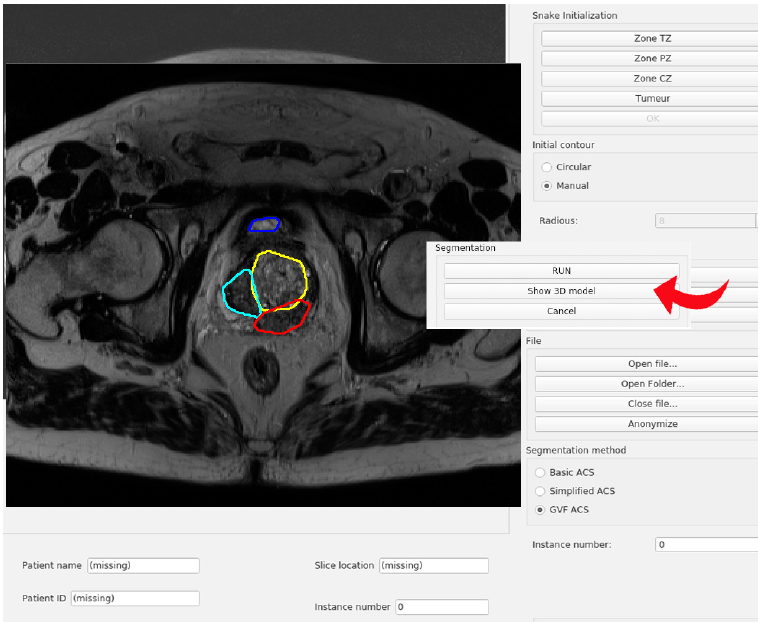
Figure 9. Example of snake results after the snake segmentation.